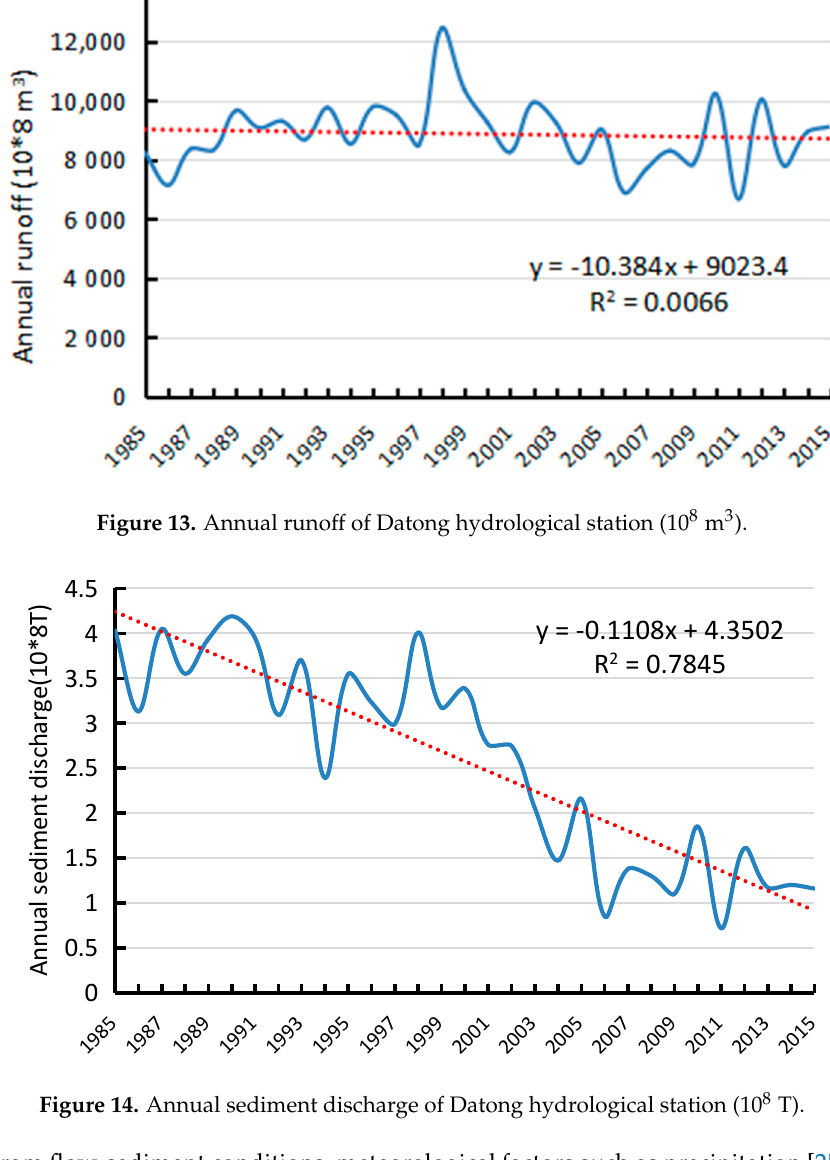
Figure 14. Annual sediment discharge of Datong hydrological station (10 8 T).